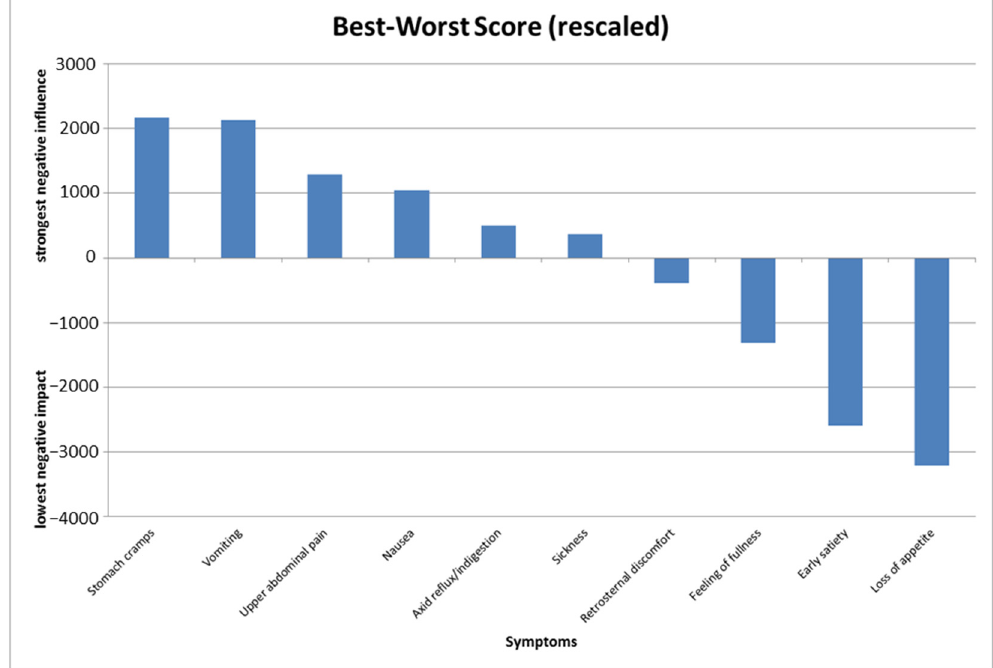
Figure 1. Best–worst scores (rescaled) of the 10 gastrointestinal symptoms. The level of the values reflects the impact of the symptoms on patients’ decisions.